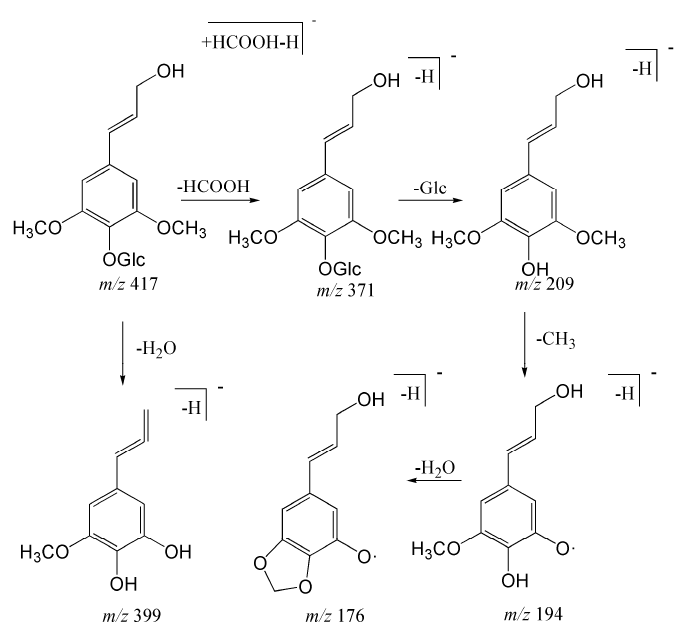
Scheme 3. The proposed fragmentation pathway of trans -syringin.